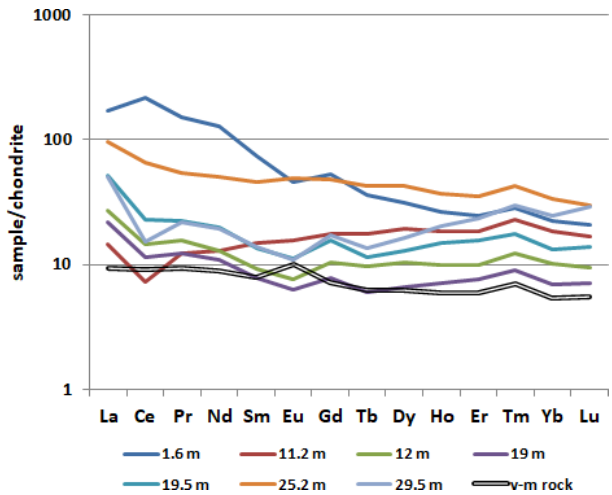
Figure 10. Chondrite-normalized (Taylor and McLennan, 1985) REE pattern of the brown iron ore and volcanomictic rocks (v-m